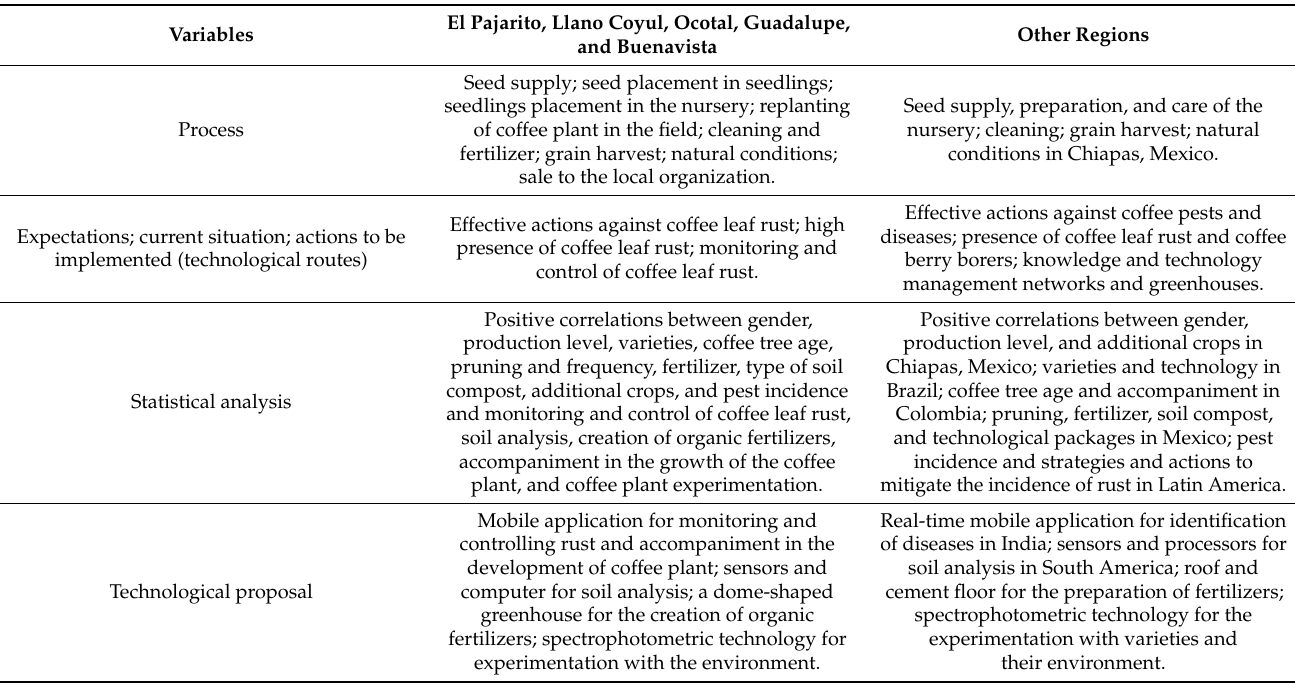
Table 9. Discussion of process, routes, statistical analysis, and technological